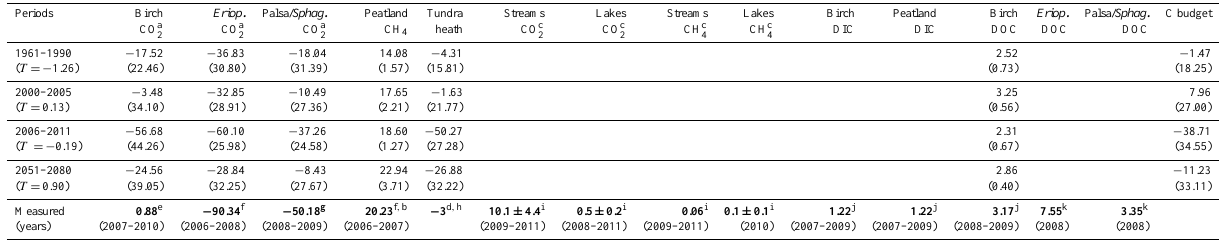
Table 2. Summary of catchment C budget for different time periods. Both mean and annual variations (1-standard-deviation value in the parentheses) of each period are presented. Negative mean values indicate ecosystem carbon uptake, while positive values indicate that mean ecosystem carbon is lost through respiration or CH 4 emission. The mean temperature ( T , ◦ C) of each period is listed. Periods